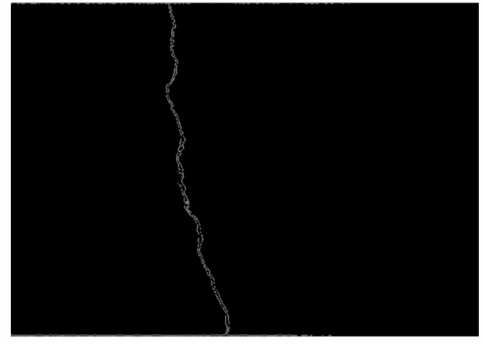
Figure 7. Image after noise